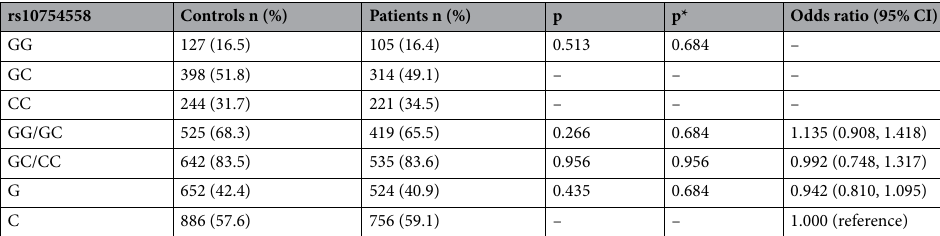
Table 2. Genotype and allele frequencies distribution of the NLRP3 rs10754558 in the patients with sepsis and healthy controls. 95% CI 95% confidence interval. *False discovery rate-adjusted p-value for multiple hypotheses testing using the Benjamini–Hochberg method.